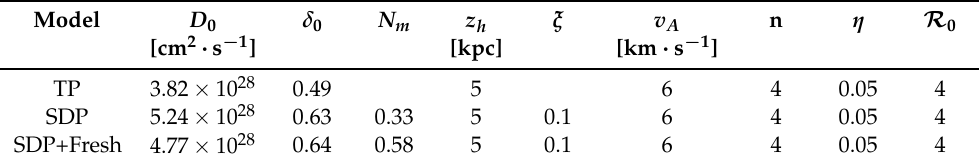
Table 1. The propagation parameters of three different models discussed in Section 2.